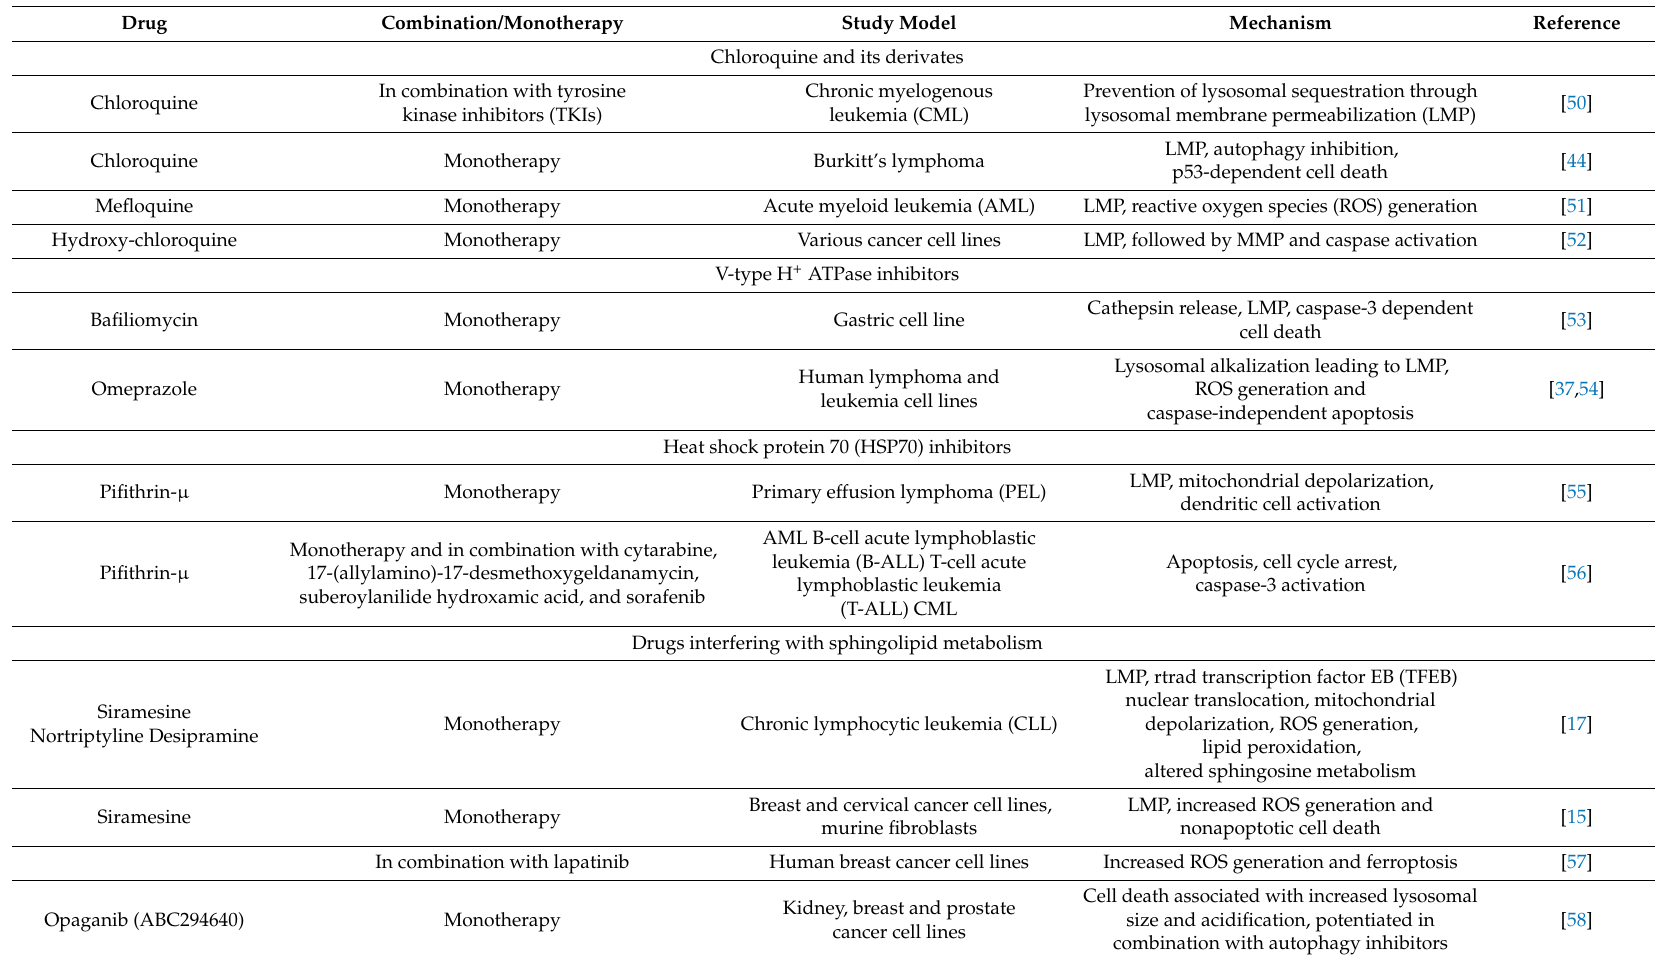
Table 1. List of typical inducers of lysosomal cell